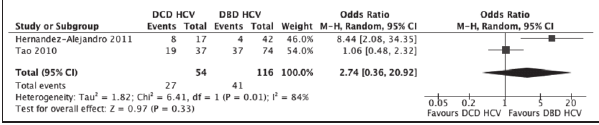
Figure 5) Forest plot of recurrence of hepatitis C virus (HCV) infection. DBD Donation after brain death; DCD Donation after cardiac death